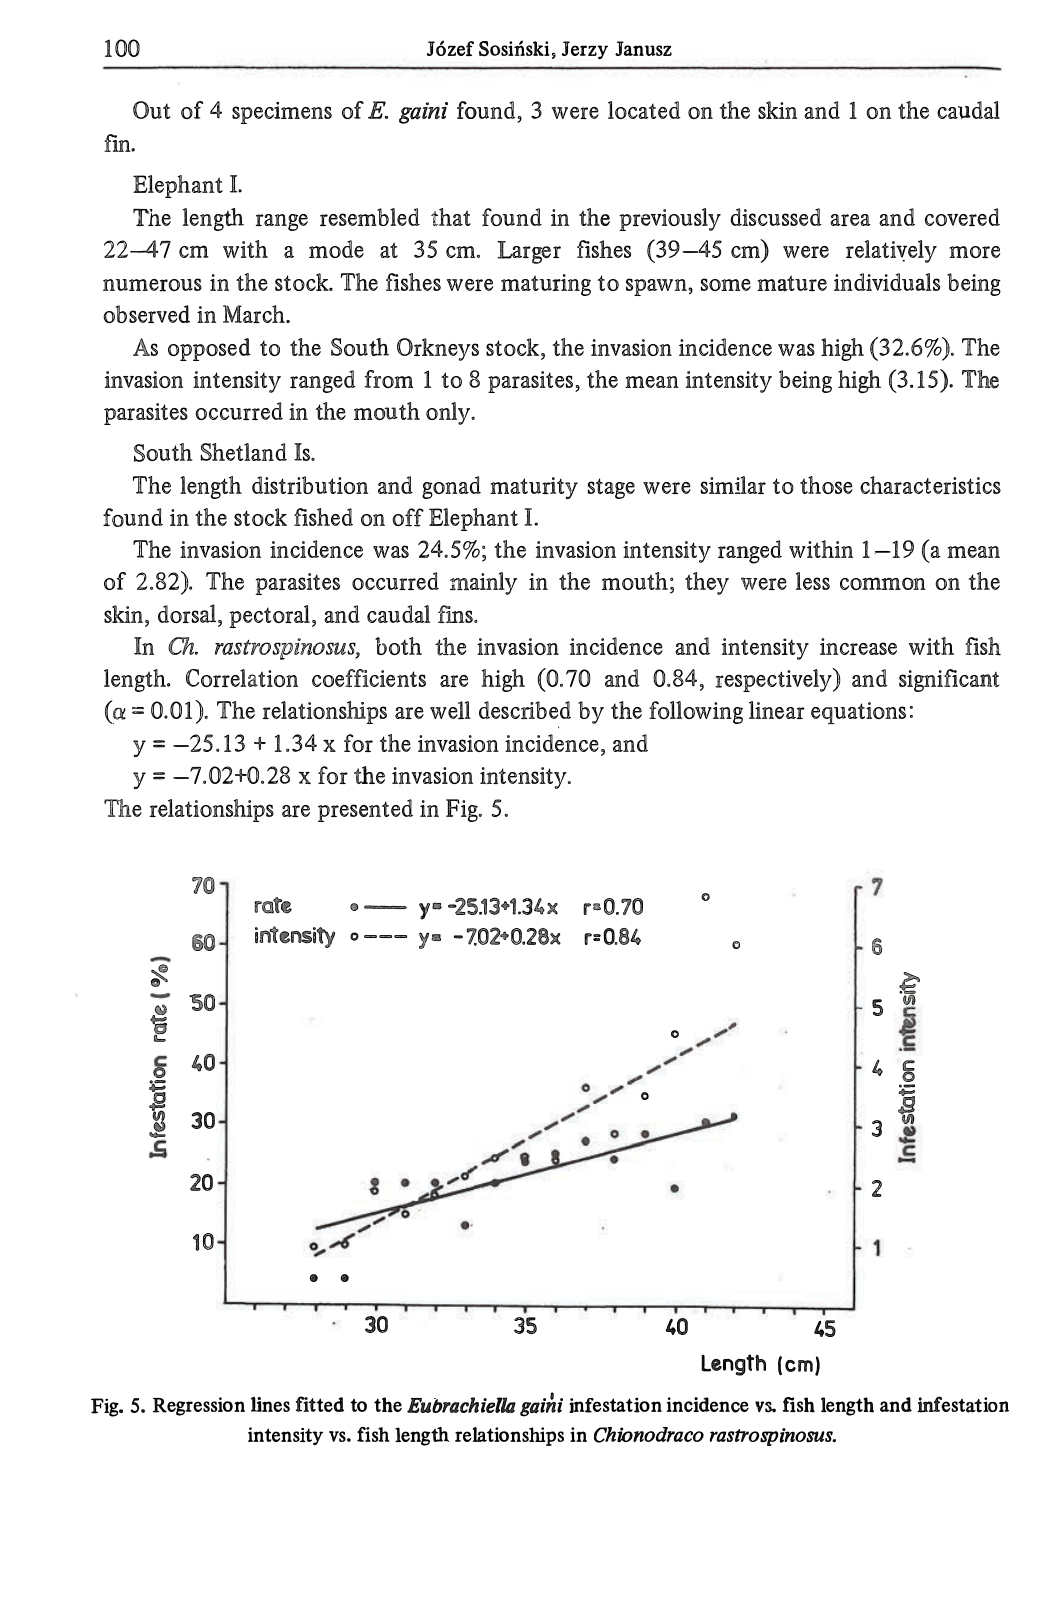
Fig. 5. R egression lines fitted to the Eubrachiella gaini infestation incidence vs. fish length and infestation intensity vs. fish length relationships in Chionodraco